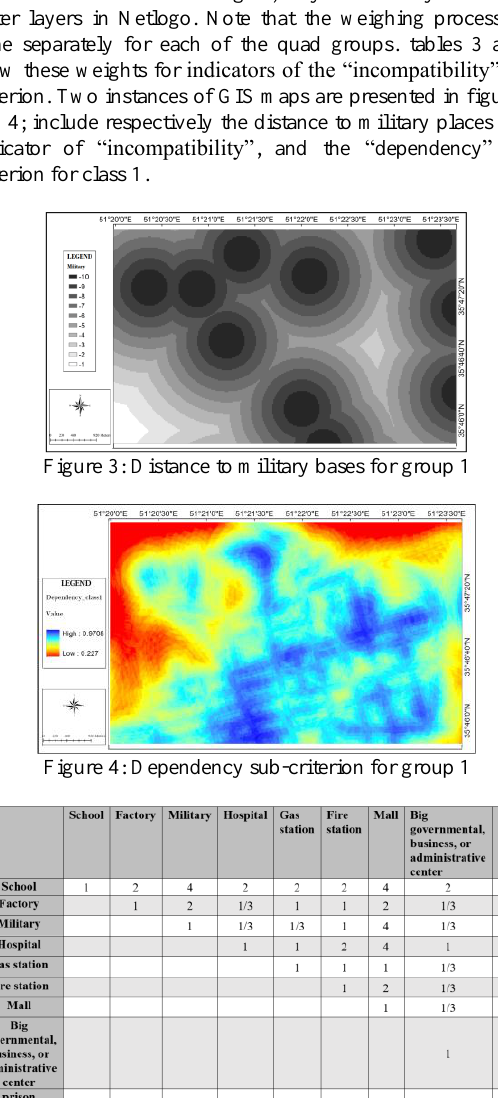
Table 3: Qualitative weights of incompatibility indicators for groups 1 and 2